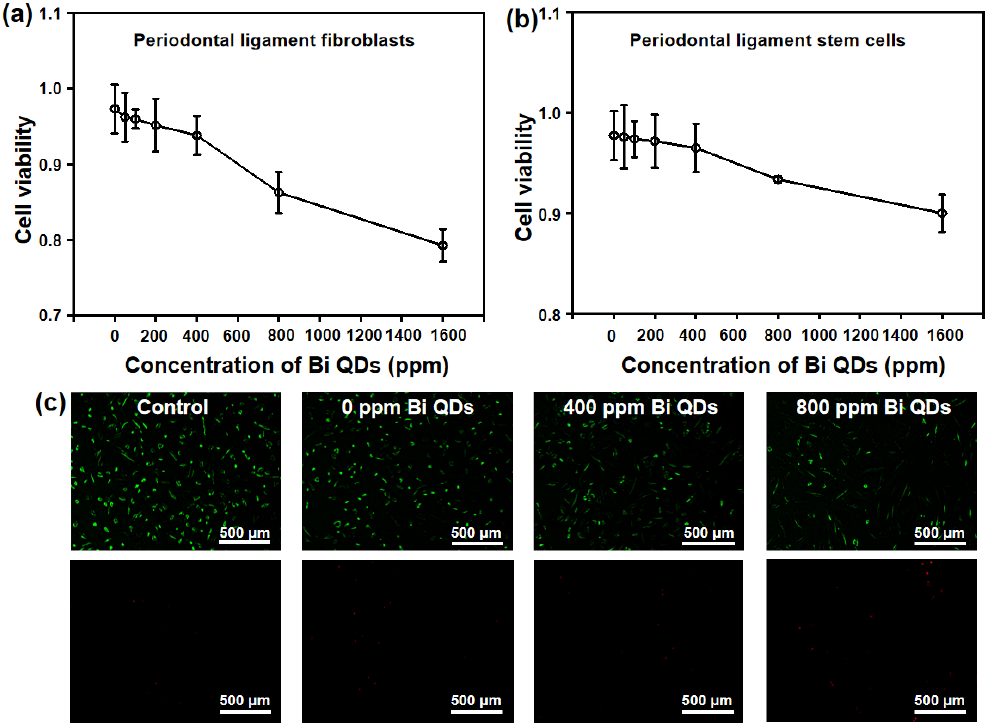
Figure 7. Cytotoxicity of the Bi QD/PDMS-modified tooth with different concentrations of Bi QDs toward ( a ) periodontal ligament fibroblasts and ( b ) periodontal ligament stem cells. The two curves are normalized based on the control groups. ( c ) Live/dead fluorescence images for the periodontal ligament fibroblast cell viability treated by Bi QD/PDMS-modified tooth with different concentrations of Bi QDs for 24 h in the dark. The periodontal ligament fibroblast cells were stained by Calcein-AM/PI Double Stain kit.